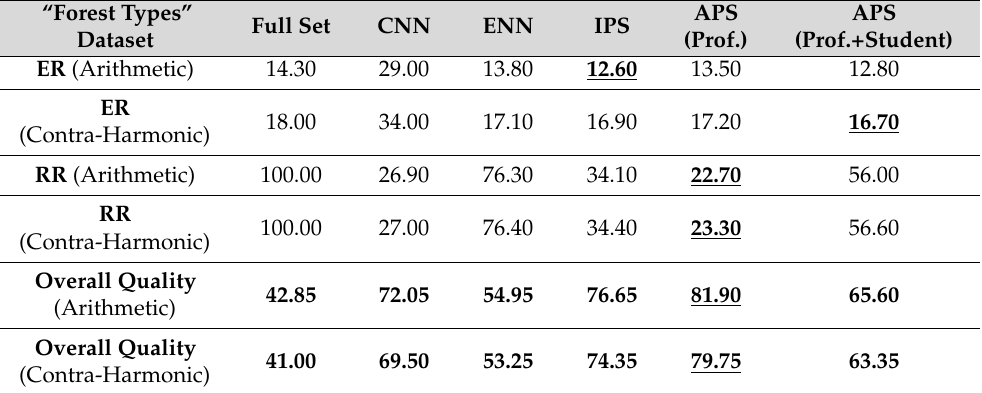
Table 7. Results of the experiments with the Forest Type Mapping